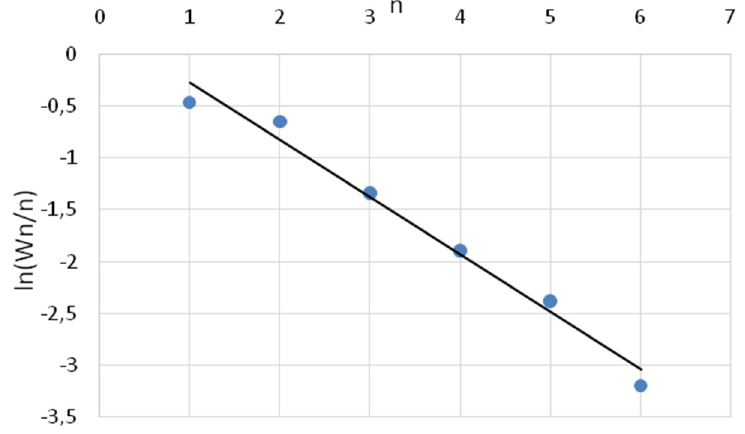
Figure 4. Typical Anderson-Schulz-Flory pattern for alcohol distribution.